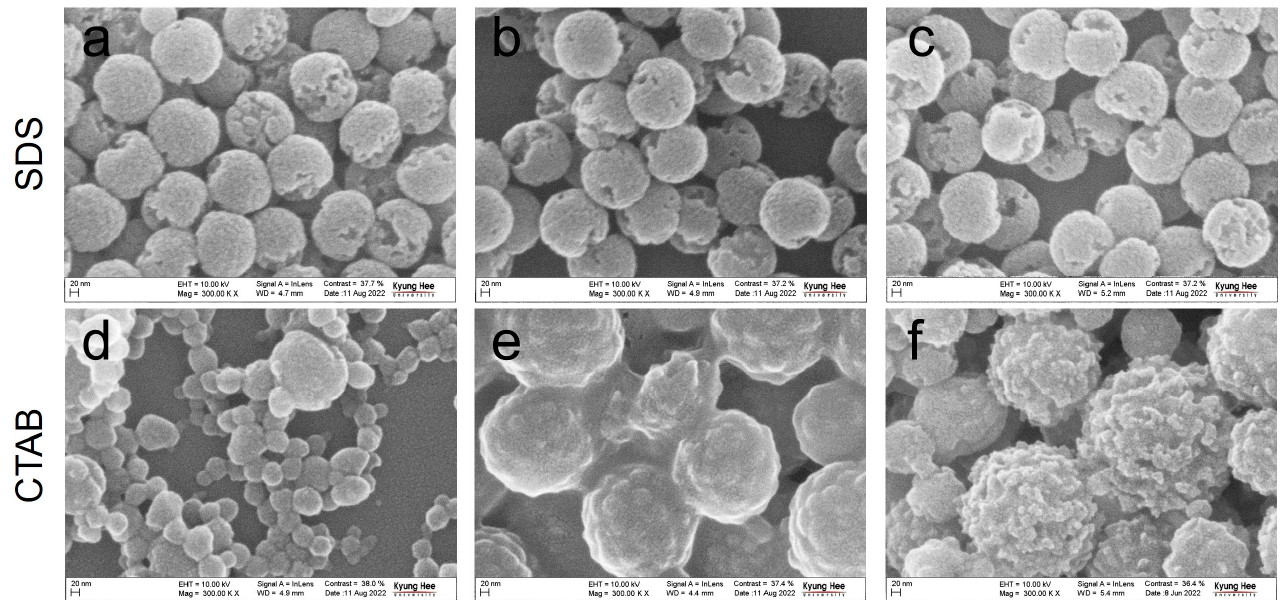
Figure 4. SEM images of partially etched PS NPs after chemically etching them using different sol- vents: THF ( a , d ), chloroform ( b , e ), and toluene ( c , f ). The top and bottom are the PS NPs polymerized in the presence of SDS and CTAB surfactants, respectively, where t DVB = 70 min for all the